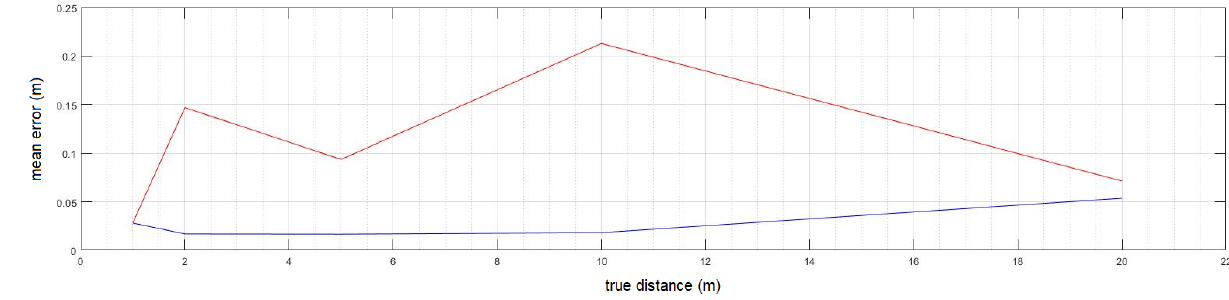
Figure 9. Mean error with (red) and without (blue) the aluminum foil covering the door behind the transceiver.